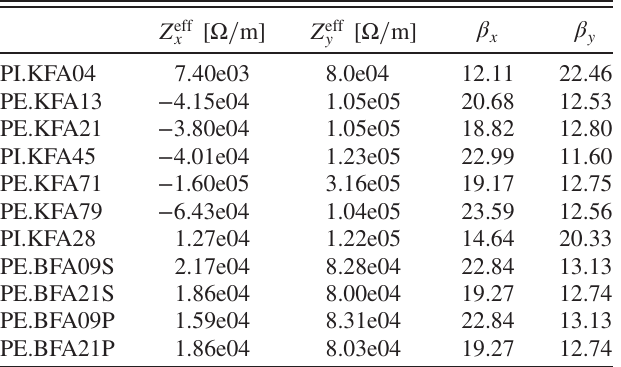
TABLE V. PS Kicker imaginary parts of effective horizontal and vertical impedances weighted by the β function defined in the 2 GeV lattice.